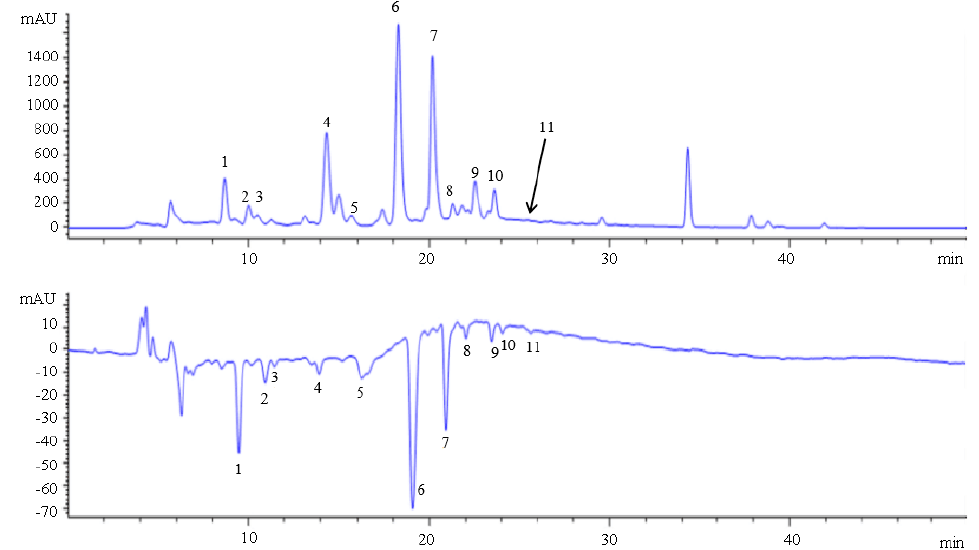
Figure 3. Antioxidant components of ethyl acetate extract from fig leaves by online HPLC-DPPH. 1. 3-O-(rhamnopyranosyl-glucopyranosyl)-7-O-(glucopyranosyl)-quercetin; 2. 2-carboxyl-1, 4-naphthohydroquinone-4-O-glucopyranoside; 3. luteolin 6-C-glucopyranoside, 8-C-arabinopyranoside; 4. schaftoside; 5. isoorientin; 6. isoschaftoside; 7. rutin; 8. 2 ″ -O-rhamnosylvitexin; 9. isovitexin; 10. isoquercetin; 11. kaempferol-3-O-rutinoside.